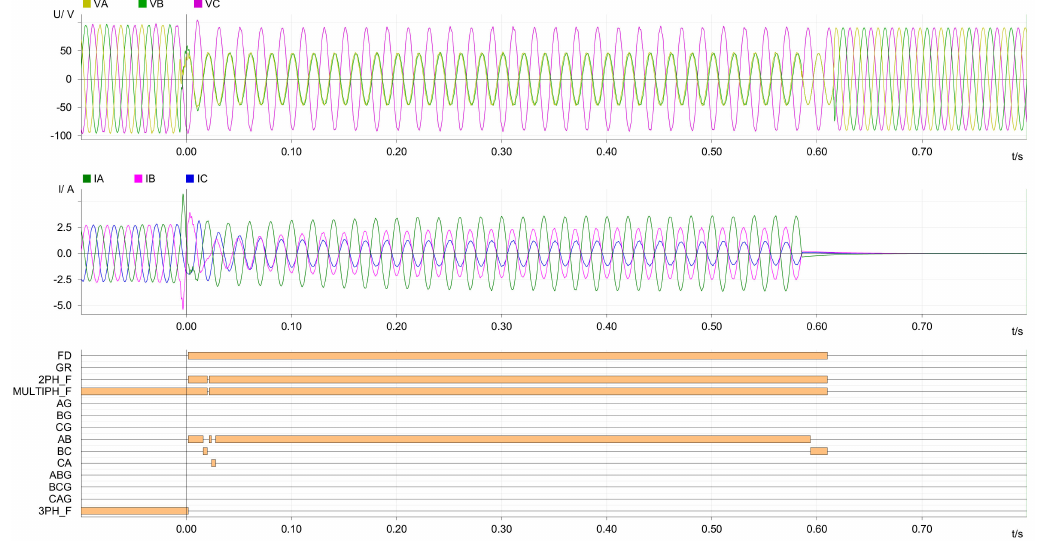
Figure 14. Faulted phase selector when AB fault is applied and K - factor = 2.5 using Strategy